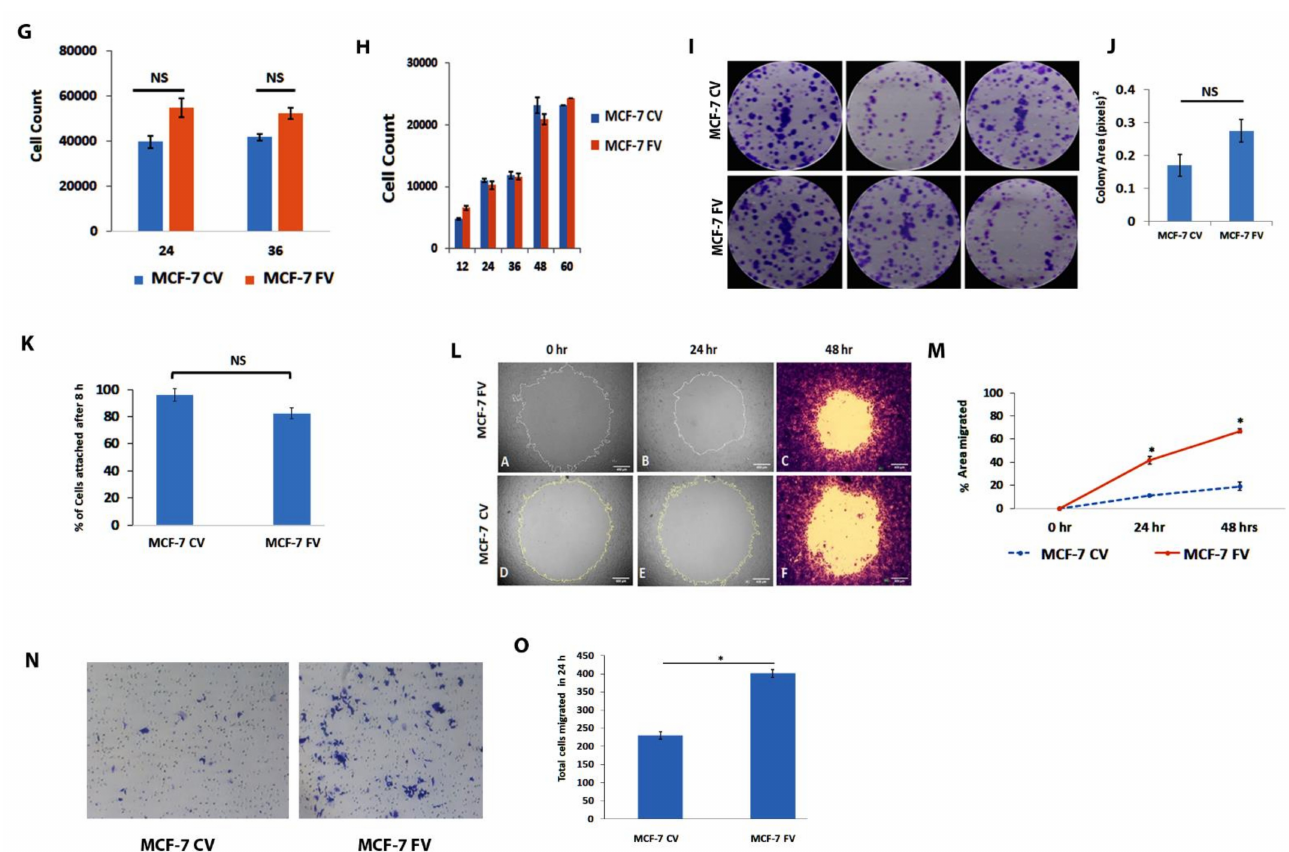
Figure 2. Characterisation of vimentin-expressing MCF-7 cells. Relative log2-fold expression of mRNA for VIM ( A ); KRT 8 ( B ), KRT 18 ( C ), KRT19 ( D ) genes normalised to POLR2A and YAP1